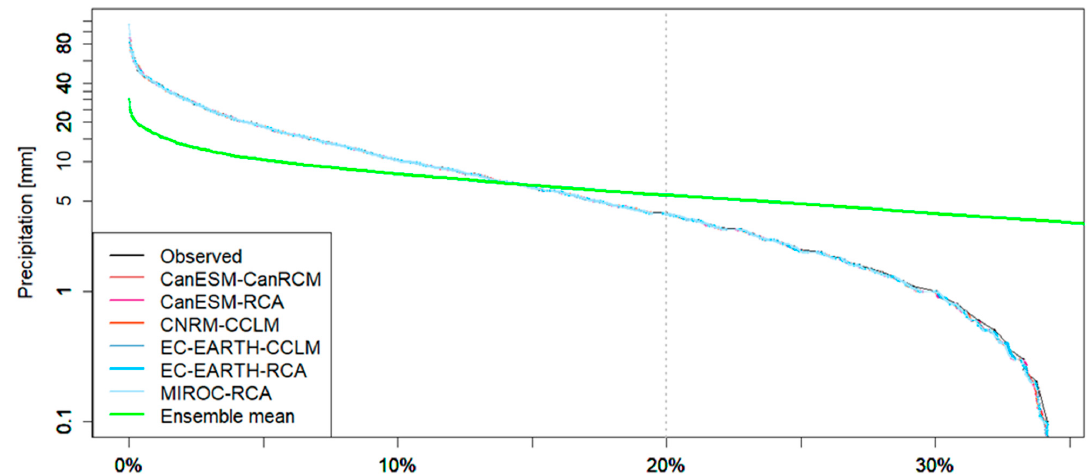
Figure 5. Exceedance probability for the six bias-corrected RCMs, their ensemble mean (arithmetic mean), and the daily observed precipitation for the period 1976–2005. Missing precipitation values were ignored in this illustration. Dry days were included in computation of the probability curve. Exceedance probability lines for observed precipitation and models are superimposed due to their similar exceedance probabilities after bias correction.